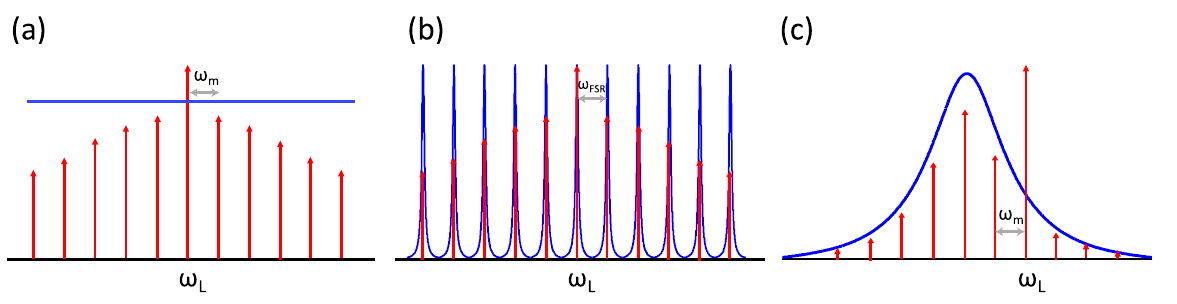
Figure 4: Generation of harmonics and optical frequency combs (OFCs) in photonic structures. (a) In an optical waveguide, a cascaded Brillouin process gives rise to a set of harmonics spaced ω m between them; (b) in a traveling-wave resonator supporting a series of high- Q whispery-gallery modes (WGMs) with a Kerr non-linearity, a set of harmonics is generated via four- wave mixing with a spacing ω FSR from the laser frequency, where ω FSR corresponds to the free-spectral range (FSR) of the resonator; (c) in an OM cavity, OM interaction induced by a blue-detuned laser scatters photons at frequencies ω m apart from the laser frequency, which in a cascadedprocessgeneratedmorephotons,givingrisetoaseriesofharmonics,andultimatelytoOFCsoccupyingthecavityopticallinewidth. In the fi gure, the blue curves stand for the photonic response of the structure and the red arrows show the different